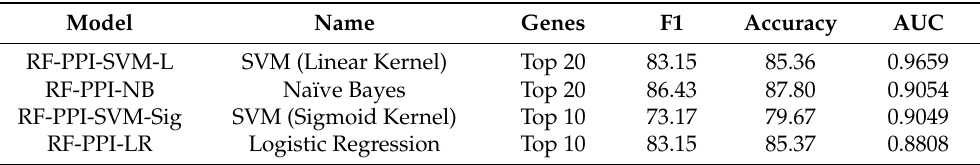
Table 5. Model performance (validation data set) using biomarkers discovered through random forest and mapped by protein–protein interaction network.